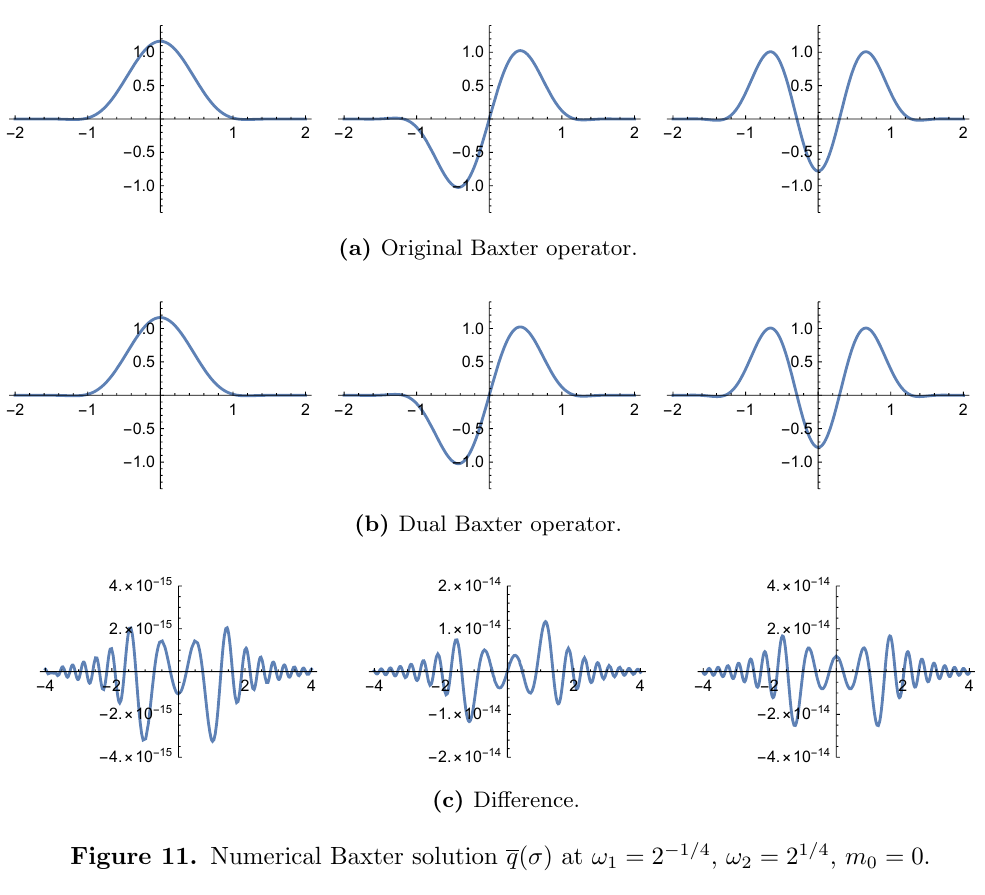
Figure 11. Numerical Baxter solution q ( (cid:27) ) at ! 1 = 2 (cid:0) 1 = 4 , ! 2 = 2 1 = 4 , m 0 =